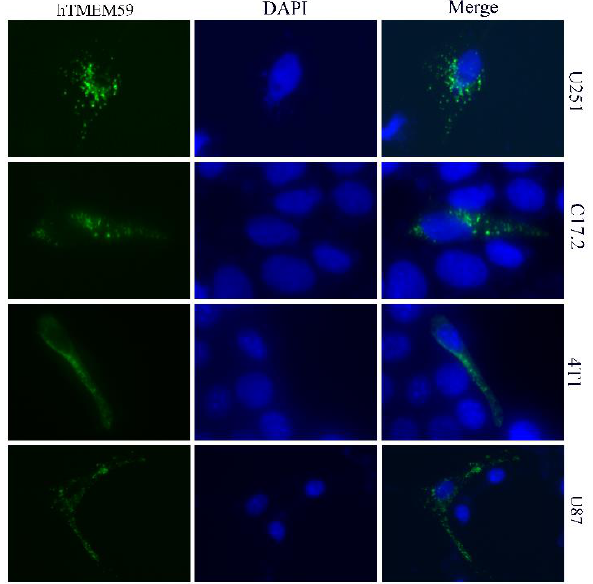
Figure 1. Intracellular localization of the human TMEM59 (hTMEM59) in different cells. U251, C17.2, 4T1, and U87 cells were transiently transfected with pEGFP-N2-hTMEM59, and 24 h later, the cells were observed under a fluorescence microscope and photographs were taken. The data showed that hTMEM59 is localized to vesicular structures in the cytoplasm and to the perinuclear region. DAPI represents cells and reflects the intracellular location of TMEM59.